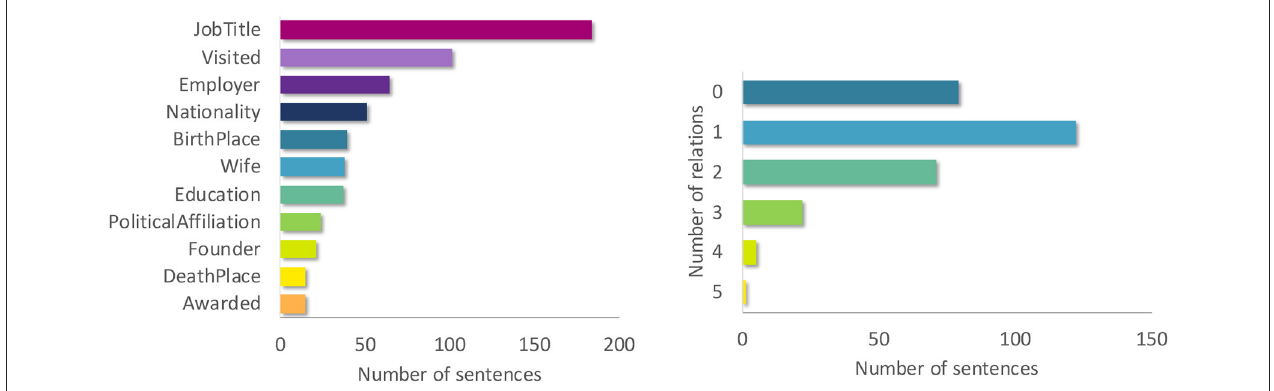
FIGURE 1 | (Left) Label distribution of the 11 relation types in the relation detection dataset. (Right) Number of relation types per sentence in the relation detection